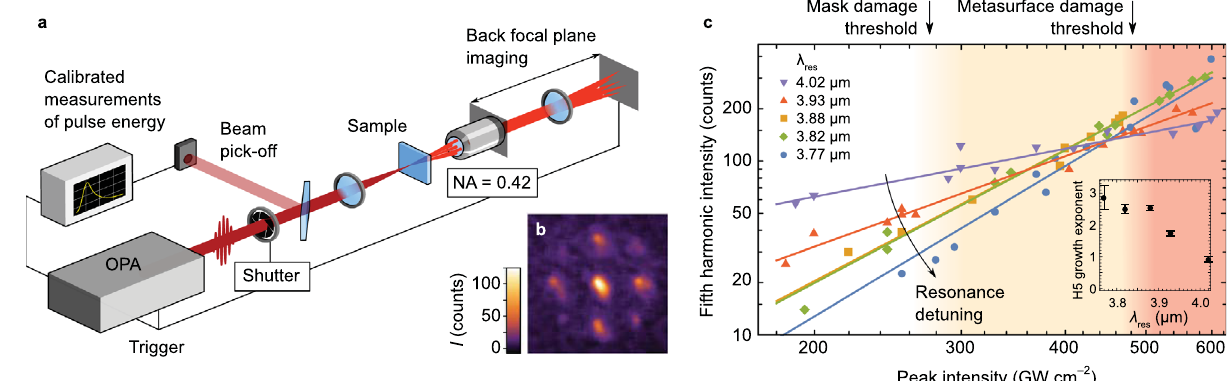
Fig. 3 Single-pulse (SP) fi fth harmonic generation reveals the non-perturbative regime and high damage thresholds of resonant metasurfaces. a A setup for SP-HHG back focal plane (BFP) imaging. Single pulses from an optical parametric ampli fi er (OPA) pass through a mechanical shutter, split into the main beam (sample irradiation) and the pick-off beam (individual pulse power calibration). The diffracted harmonics are collected by an objective lens with a numerical aperture of NA = 0.42 and detected in the BFP con fi guration by triggered camera exposure. b A typical BFP image of the H5 from the resonant sample at non-destructive intensities. c Zeroth diffraction order intensity of the H5 as a function of MIR pump intensity for fi ve different metasurfaces with resonances at λ res , from the farthest from (blue circles) to the closest to (purple triangles) the driver wavelength. Solid lines: best fi ts to the power law I ð 5 Þ ¼ aI b . Deviation from the expected I ð 5 Þ (cid:6) I 5 indicates the saturation of nonlinear response. Inset: power exponent b vs. resonance wavelength λ res . The mask damage threshold and the metasurface damage threshold are shown for the most resonant metasurface λ res ¼ λ ð 0 Þ